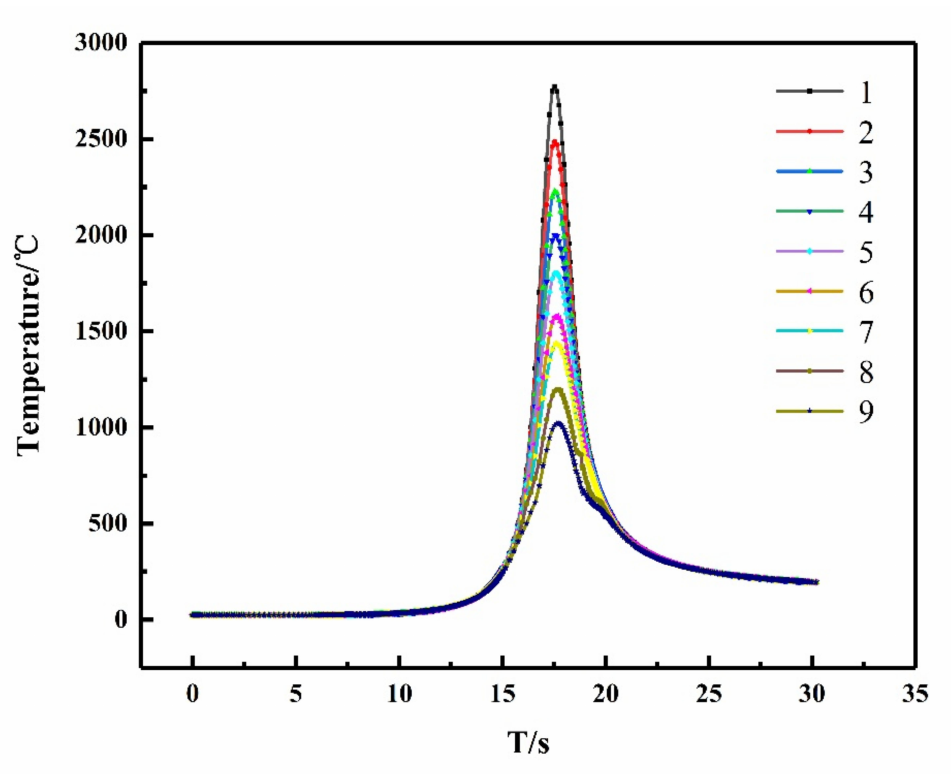
Figure 7. Thermal cycle